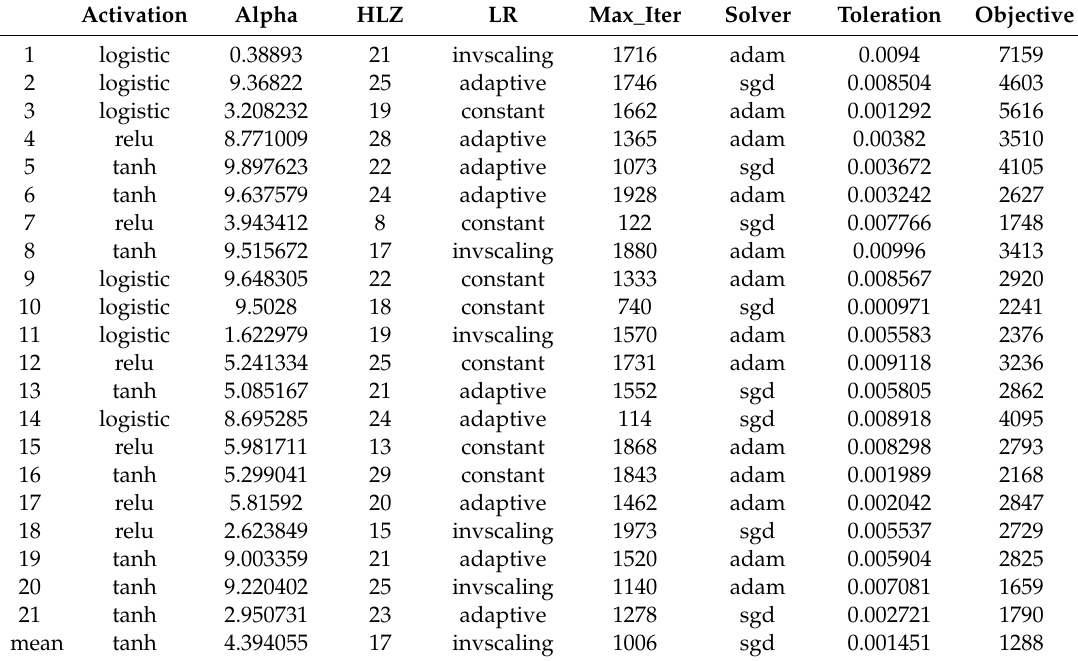
Table A1. Optimal results of Bayesian hyper-parameter optimization for MLP for this region.